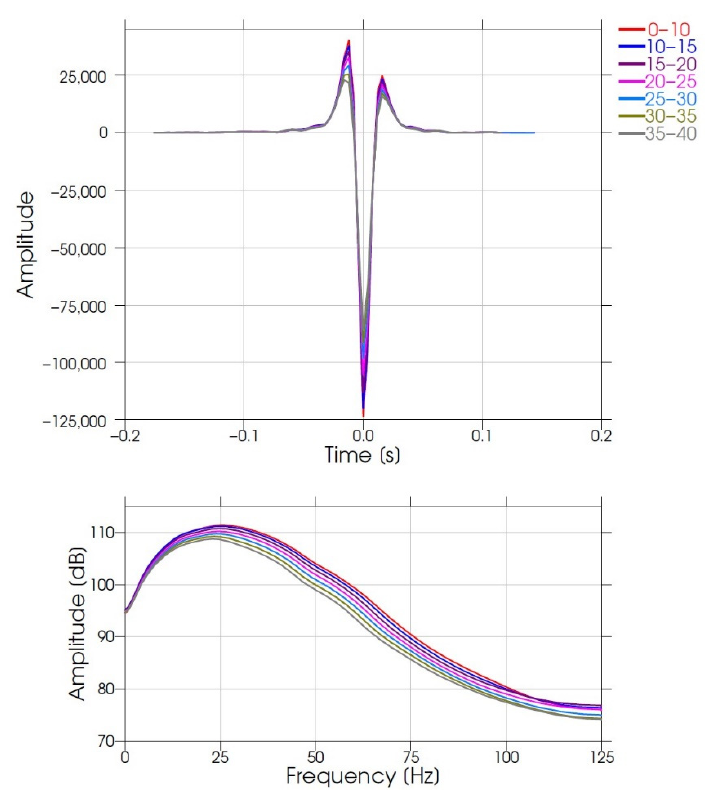
Figure 12. Statistical wavelets extracted from seven partial angle stacks extracted from a fixed time window around the Upper Cretaceous.